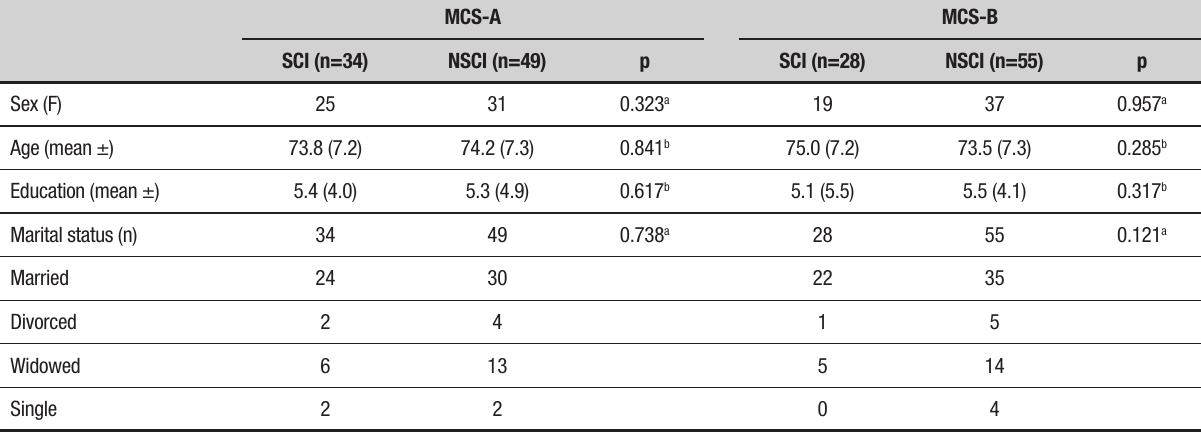
Table 1. Sociodemographic and clinical variables based on SCI levels, according to the MCS-A and MCS-B.